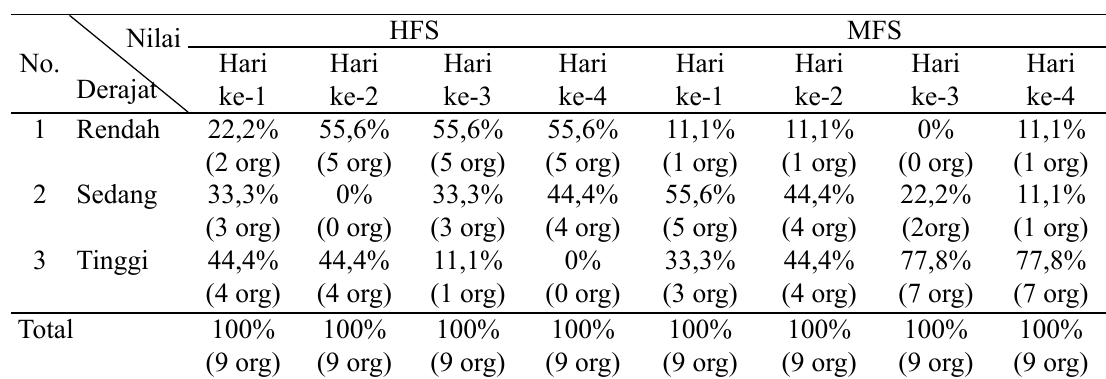
Tabel 5. Hasil penilaian derajat risiko jatuh dengan HFS dan MFS berdasarkan jenis